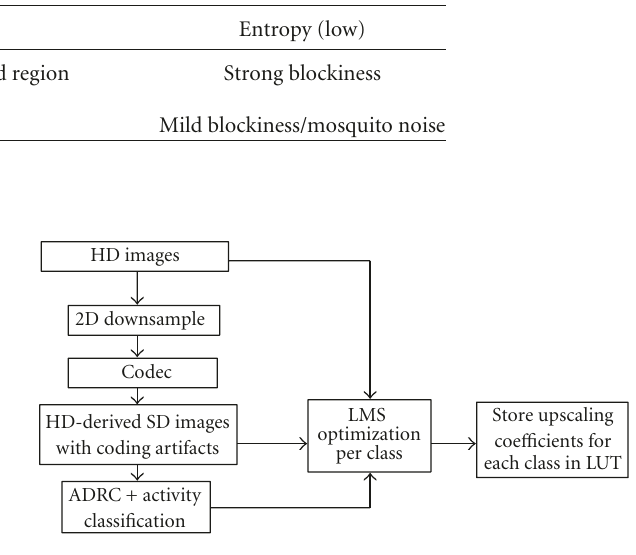
Figure 2: The training procedure of the proposed